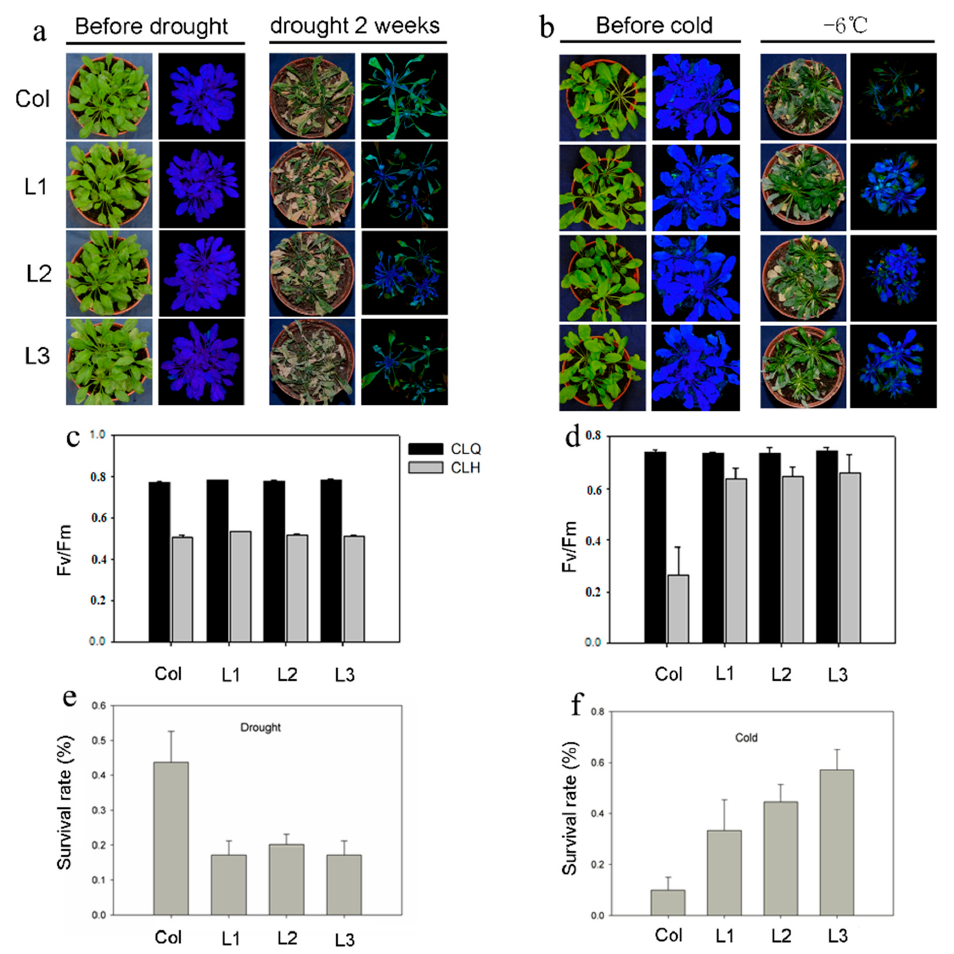
Figure 2. Seedling growth and survival of ScCBL6- overexpressing ( ScCBL6 -OXP) and wild-type (WT) plants under drought and cold stress. The upper panels ( a , b ) indicate the changes in the mor- phology and photosynthetic efficiency (Fv/Fm) after drought and cold treatment. Left-hand images (green plants) were obtained in live video mode, while right-hand images (blue plants) were ob- served under fluorescence light. The lower panels ( c – f ) show the survival rate of different transgenic lines (L1–L3) after controlled drought and cold treatments and are based on at least seven biological replicates.